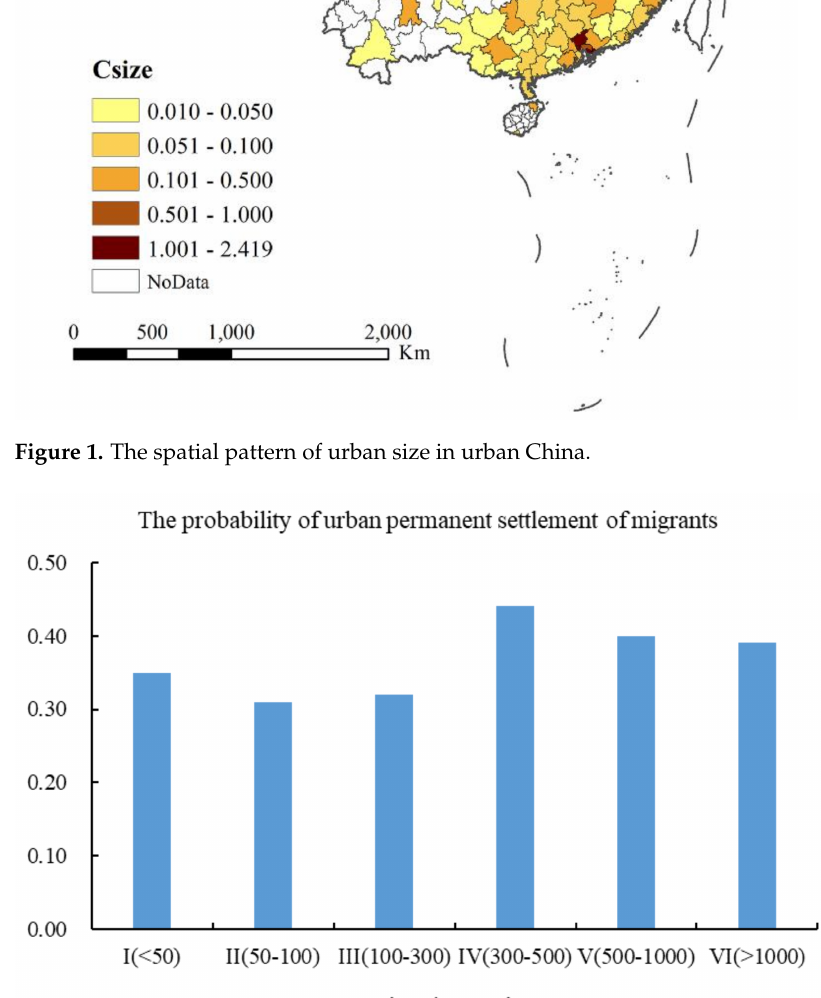
Figure 2. City size and the probability of settling permanently in the